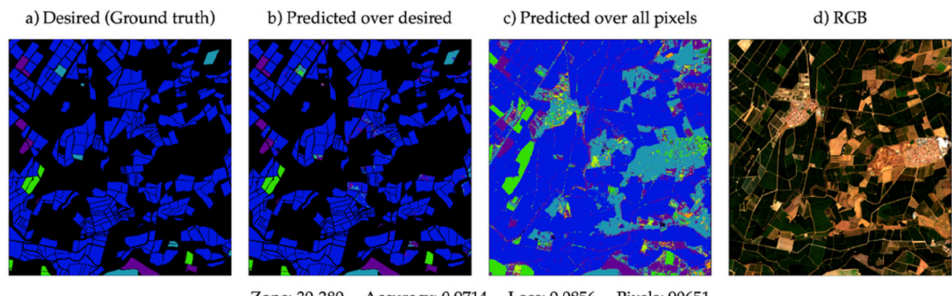
Figure 15. Prediction example of zone